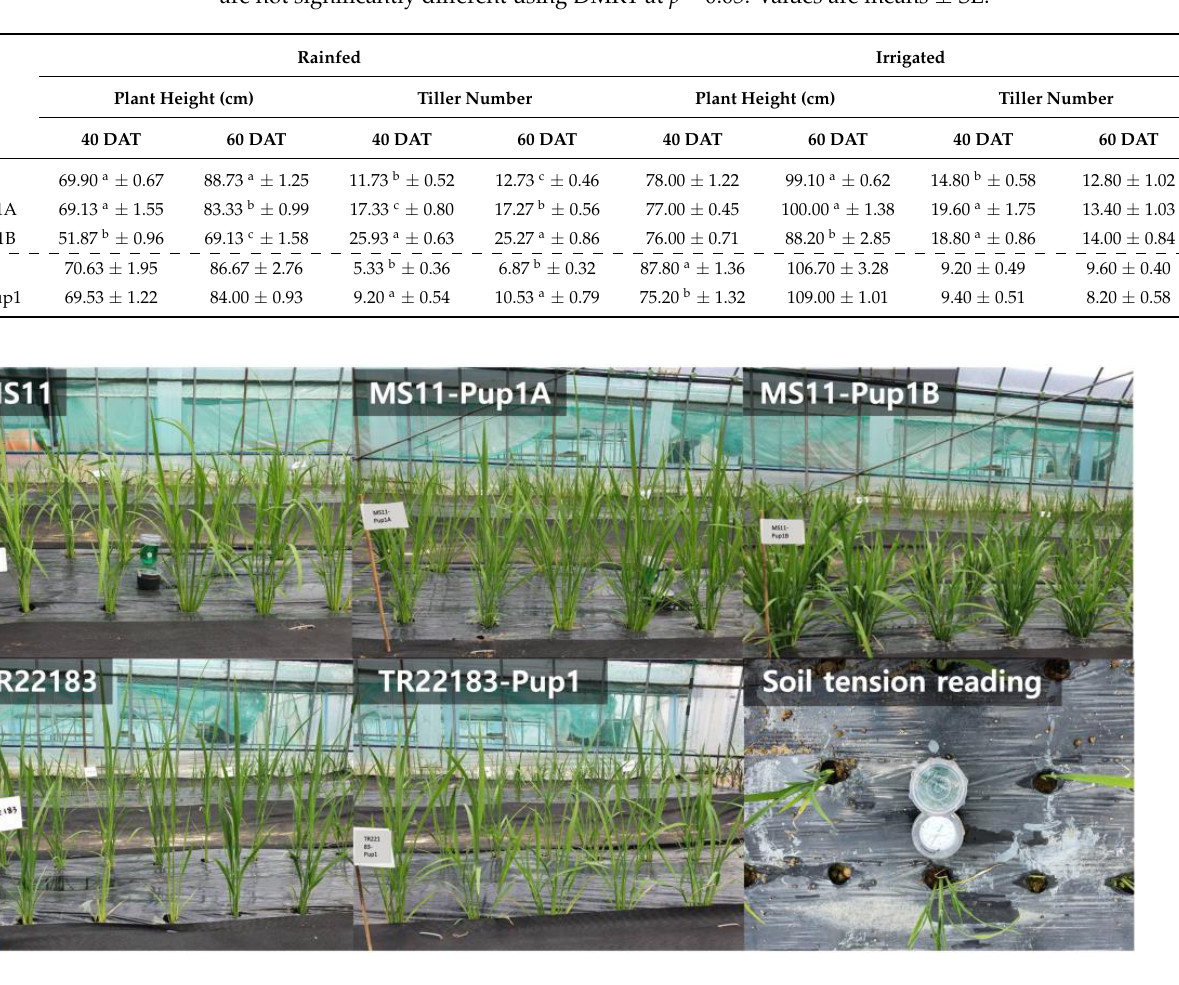
Table 4. Reproductive stage response of temperate-Pup1 introgression lines and control varieties grown under rainfed and irrigated conditions (2022). Means with the same letters within a genetic background and treatment not significantly different using DMRT at p = 0.05, except for days to heading. Values are means ± SE.